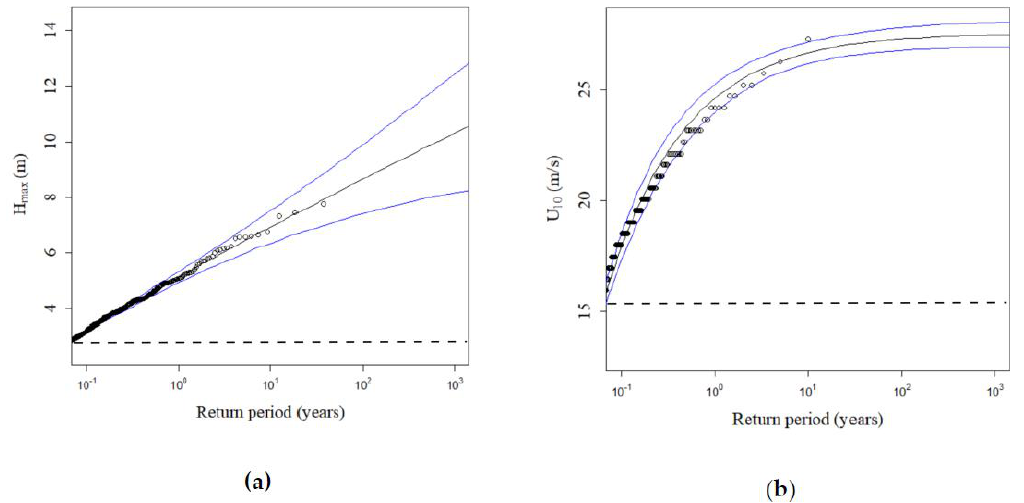
Figure 3. Generalised Pareto Distribution (GPD) profiles for wave height in metres ( a ) and wind speed in m / s ( b ). Crosses indicate storm significant wave height and wind speed values, with the GPD fit and 95% confidence intervals indicated by the three curves. Dashed line indicates the threshold level. Table 1. Summary of statistically significant storm wave boundary conditions in Carmarthen